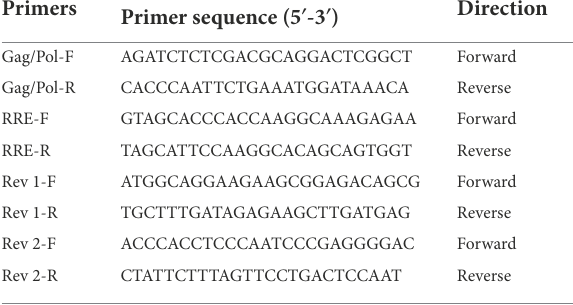
TABLE 1 Primer information for the Gag/Pol-RRE reporter gene system.